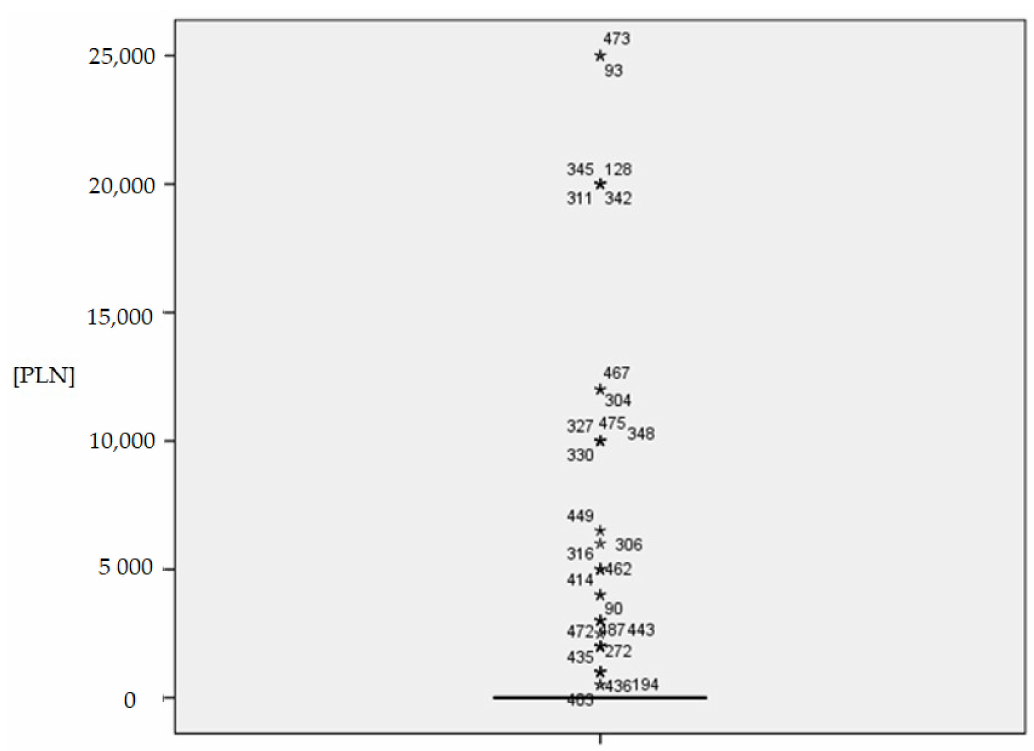
Figure 7. Boxplot of own expenses for the introduction of renewable energy sources for household